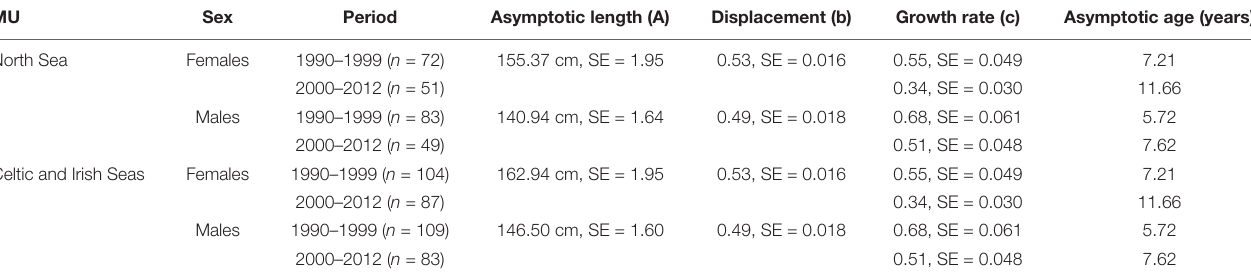
TABLE 2 | Asymptotic length (A), displacement (b), and growth rate (c) and their respective standard errors (SE) estimated using the Gompertz growth model for female and male harbor porpoises in the North Sea MU and Celtic and Irish Seas MU for the two time periods (and a year-based approach), 1990–1999 and 2000–2012. MU Sex Period Asymptotic length (A) Displacement (b) Growth rate (c) Asymptotic age (years) North Sea